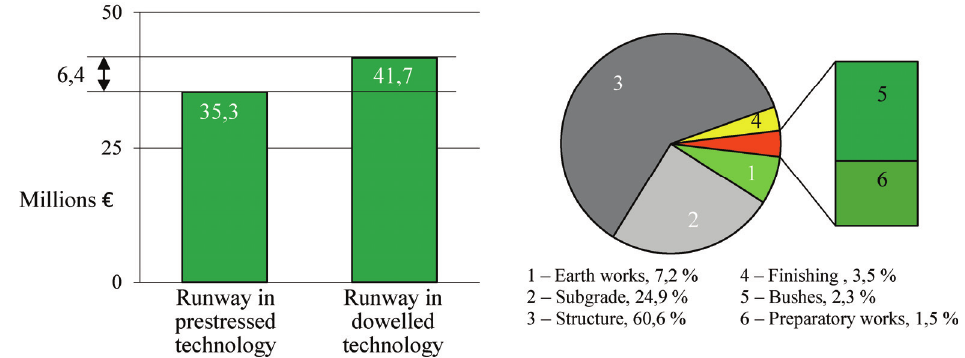
Fig. 10. Total cost estimate prices (VAT inclusive) for execution of the runway and cost structure in the case of prestressed technology [own